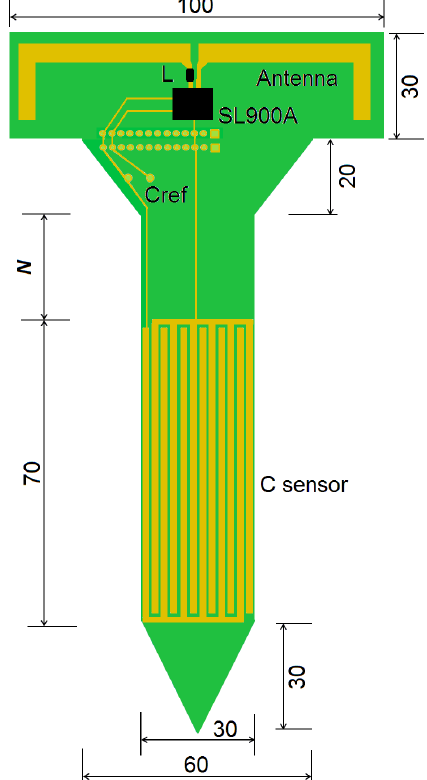
Figure 7. Design of the Soil Stick Sensor using UHF RFID chip (SL900A) and an interdigital capacitive humidity sensor ( C sensor ). A neck of N = 30 mm was defined. The arrow shape allows the tag to be stuck into soil. The whole sensor area must be buried. All dimensions are in millimeter